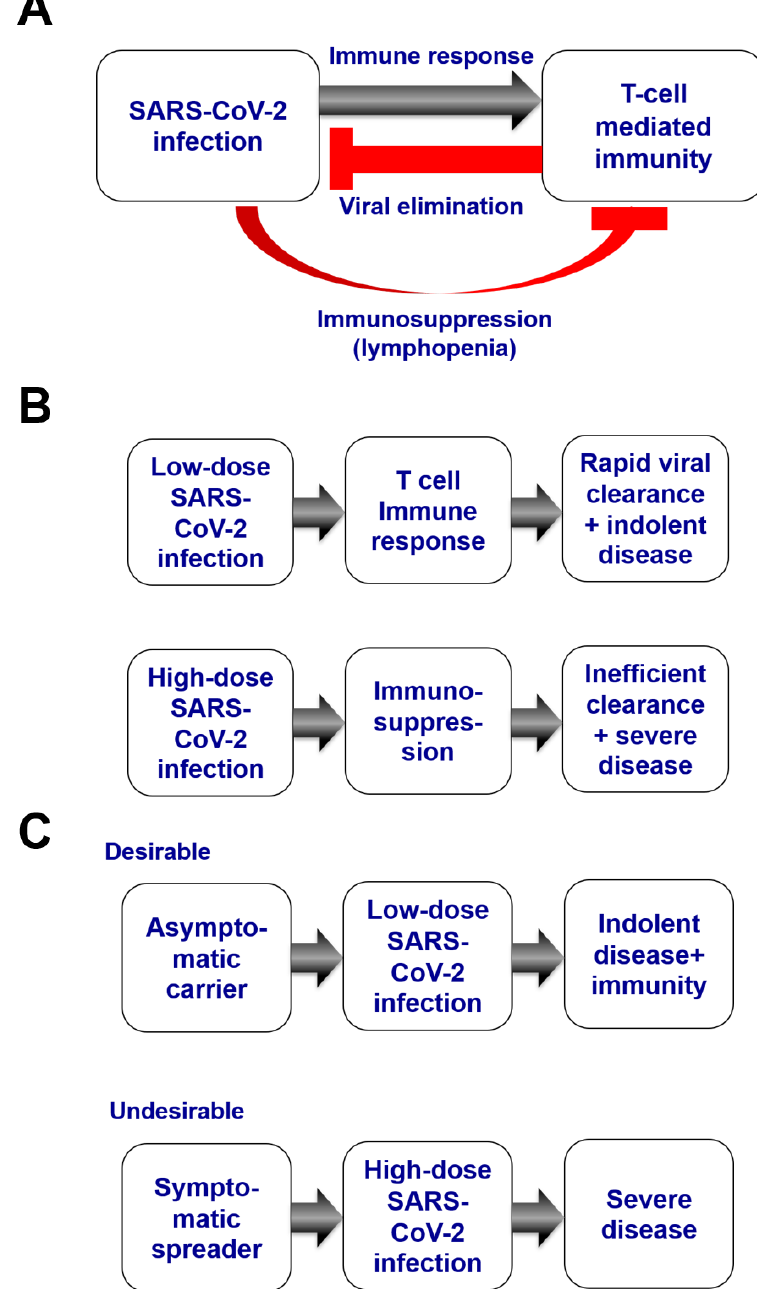
FIGURE 1 : Proposed relationships between COVID-19 and anti-SARS-CoV-2 immune responses . (A) The precarious equilibrium between SARS-CoV-2 and the immune sys- tem. While the virus elicits an immune re- sponse leading to elimination of infected cells (and hence clearance of the infection), it tends to suppress the immune response. Therefore, the outcome of infection is de- termined by the kinetics of the immune response leading to viral elimination versus viral replication leading to immunosuppres- sion. (B) Hypothetical effect of the initial contagion on the course of the infection caused by SARS-CoV-2. A low-level contagion would favor an efficient immune response and indolent infection, leading to immunity of the infected person. Transmission of a large number of viral particles would tend to cause multifocal respiratory infection leading to immunosuppression and severe illness and possibly death. (C) Possible modes of transmission of SARS-CoV-2. Indolent carri- ers would tend to transmit a low viral load to their contacts, leading to indolent disease and antiviral immune responses in immuno- competent individuals. This mode of trans- mission might be considered as desirable because it leads to population immunity if it attains a large fraction of the population. In contrast, symptomatic carriers might trans- mit larger amounts of viral particles with a higher probability of leading to severe dis-